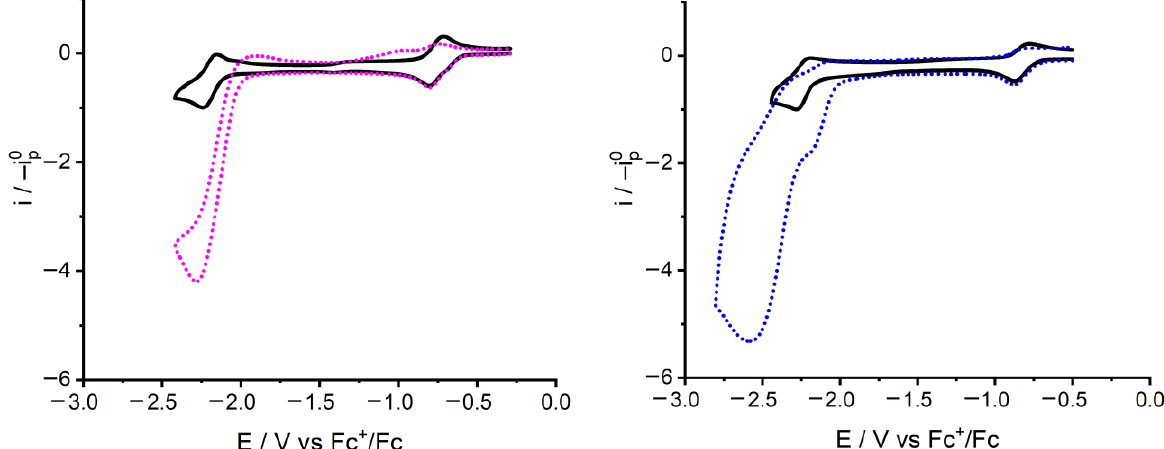
Figure 2. Cyclic voltammetries of 1 mM Fe(salen)Cl ( left ) and Fe(beacen)Cl ( right ) in acetonitrile (0.1 M Et 4 NBF 4 electrolyte), under N 2 (black, solid traces) and CO 2 (dotted traces) atmosphere. The current of the voltammetries is normalized with respect to the peak current of the Fe II → Fe I reduction wave under dinitrogen, to visualize the enhancement in the presence of CO 2 . The glassy carbon (GC) disk working electrode, Pt counter electrode, and Ag/AgCl/NaCl (3 M) were the reference electrode; potentials were then converted to Fc + /Fc by internal calibration; scan rate 0.1 Vs −1 .